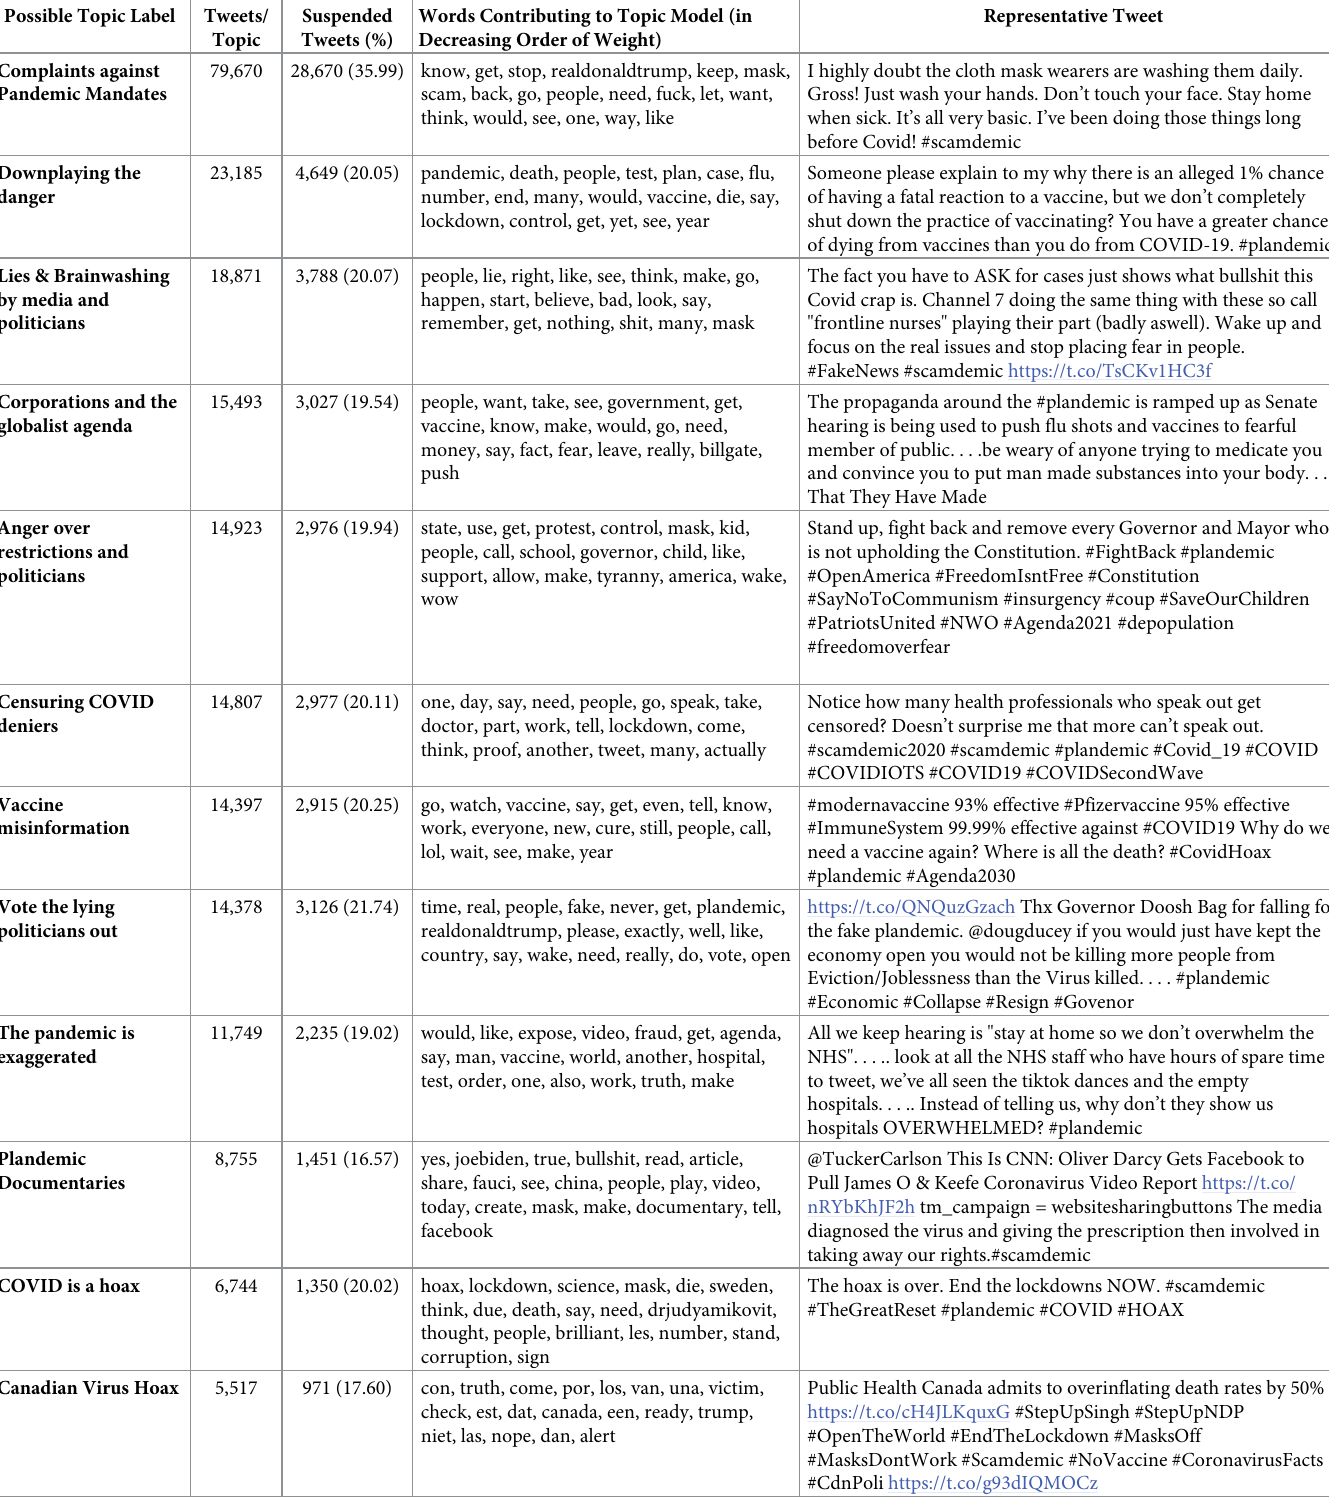
Table 4. Tweet topics, frequency, most common keywords, and sample tweets. Possible Topic